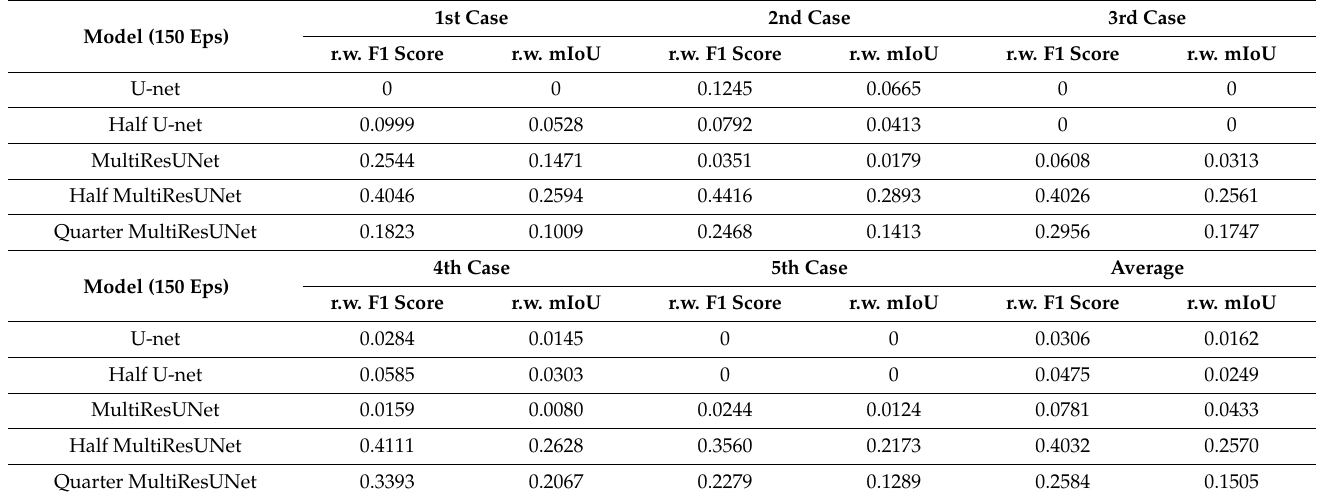
Table 3. r.w. F1 score and r.w. mIoU of five neural networks.